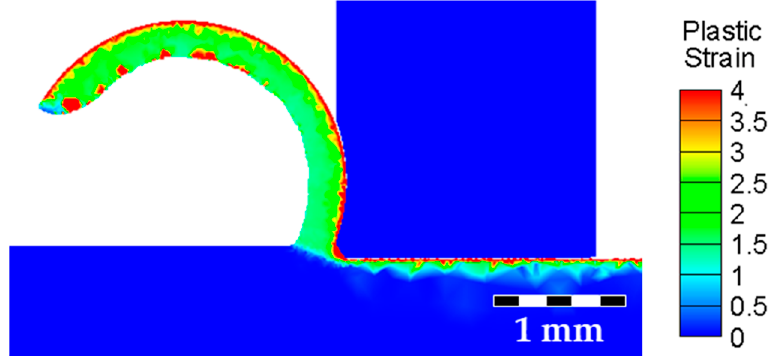
Figure 8. FE simulation result for the final chip breaker geometry.